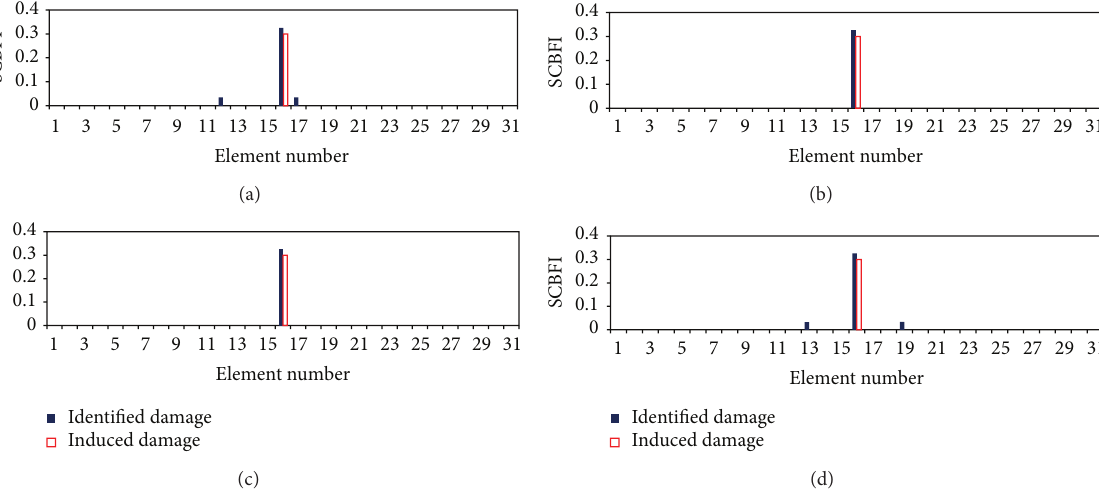
Figure 4: Damage identification for 31-bar truss for case 2 considering (a) 1 mode, (b) 2 modes, (c) 3 modes, and (d) 4 modes.